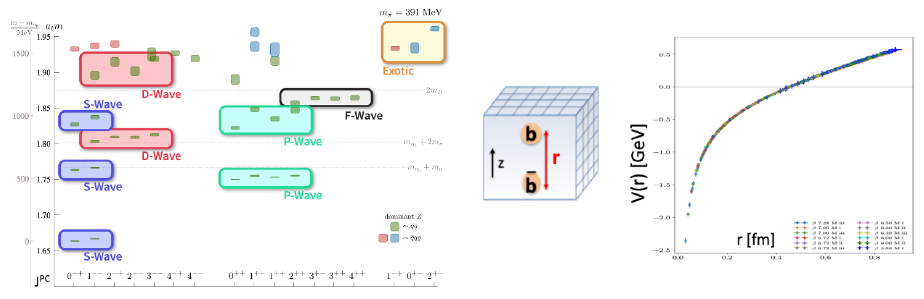
Figure 5. The ¯ bb spectrum from [24] and an example of ¯ bb static potential from [32].